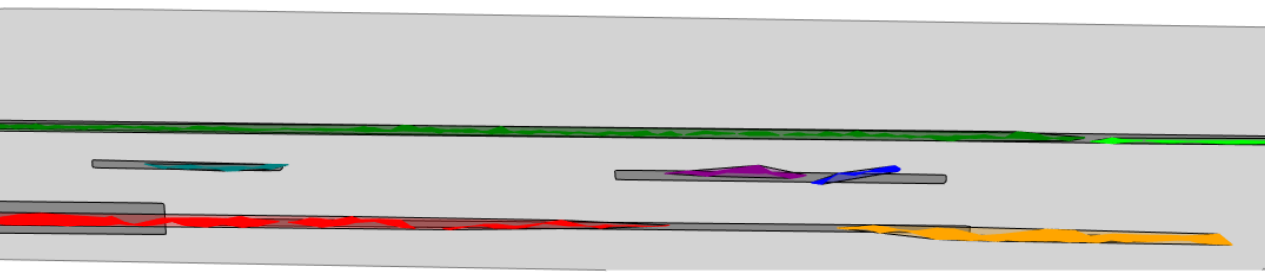
Figure 19. Road spot 4. Crack points detected with the proposed algorithm, grouped in clusters by color. Figure 20. Road spot 4. Crack clusters detected with the proposed algorithm, delimited with both convex hulls ( light color ) and alpha-shapes ( intense color ). Boxes in grey delimit the manually seg- mented cracked areas. In Table 1, the cracks that were correctly identified (considering both bigger cracks and lighter alligator cracking areas) by the algorithm against the total number of manually identified cracks are presented; in general, severe cracks manually segmented are cor- rectly identified by the algorithm, although they can be partitioned into several pieces if the degree of the damage is not continuous. Some minor cracks (mentioned above for the case studies of spots 1 and 4) were missed, and the areas affected by alligator cracking could not be correctly detected due to the reduced severity of the damage and their intri- cate patterns. Table 1. Cracks correctly identified by the algorithm at each spot. Identified Cracked Areas Spot 1